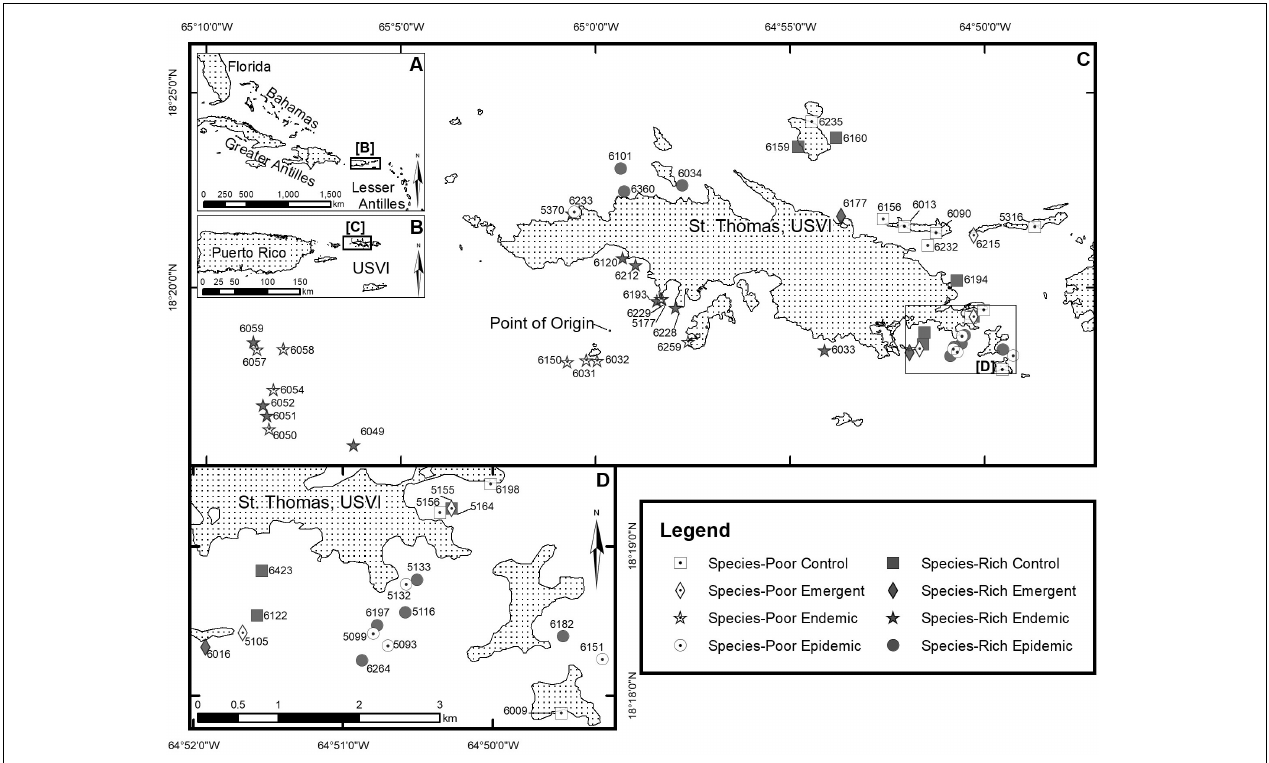
FIGURE 1 | 2020 study sites in St. Thomas, USVI shown in the (A) Caribbean Region, (B) Virgin Islands subregion, (C) study sites around St. Thomas, and (D) study sites in the SE of St. Thomas. Sites are labeled with the NCRMP site number, with the first number representing the year of initial survey (6xxx = 2017, 5xxx = 2019). Point of origin is